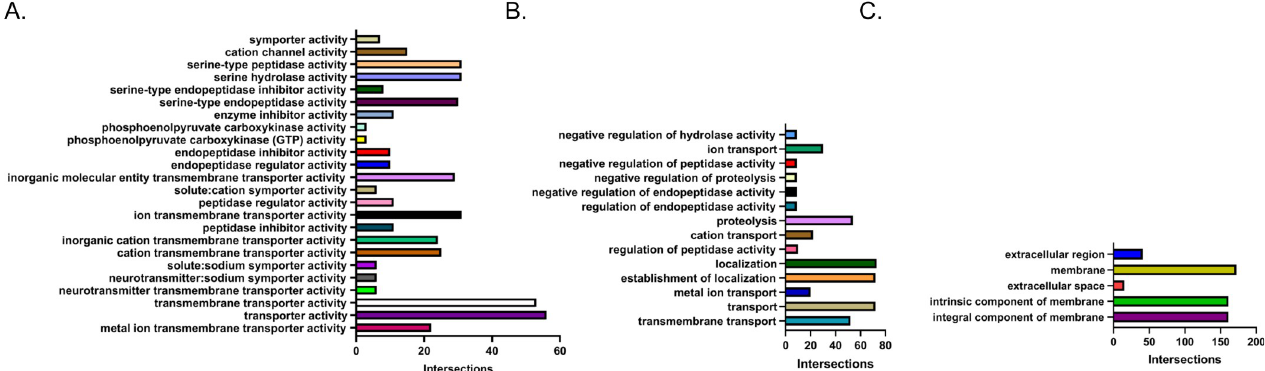
Fig 6. g:Cost functional profiling reveals genes categories that are downregulated in LD-Aag2 cells. The g:Cost Functional Profiling tool at g:Profiler was used to quantify related genes that were downregulated in LD-Aag2 cells. The number of genes that intersect with significant gene ontology (GO) categories related to (A) molecular function, (B) biological process, and (C) cellular compartment are shown.